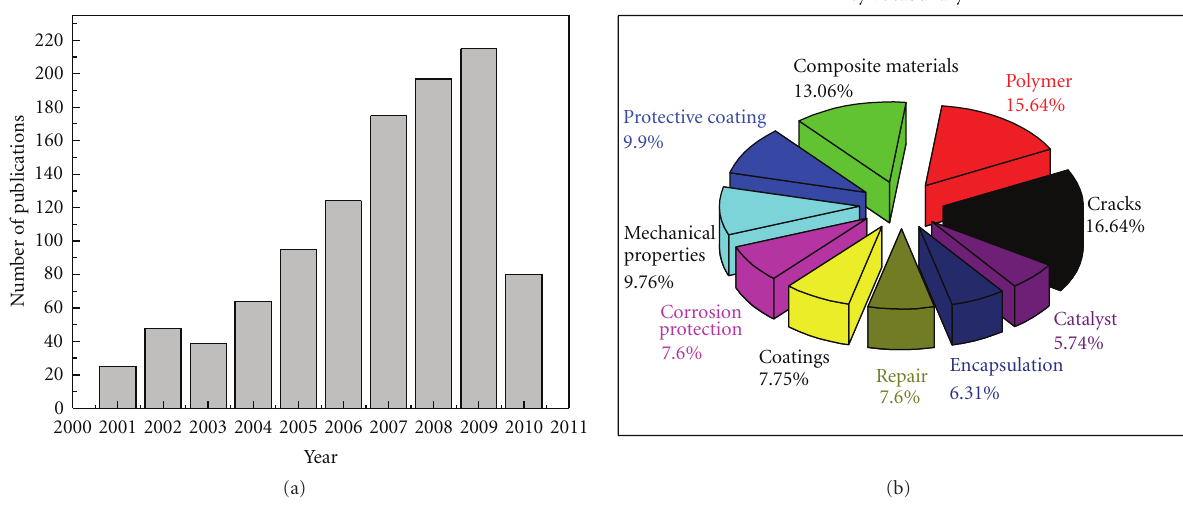
Figure 1: (a) Recent refereed publications related to the field of self healing materials, together with (b) their corresponding distribution of the employed key words vocabulary. All published languages were included. All document types, including journal and conference articles, report paper, conference proceeding, and monograph published chapters were recorded. Statistics are available from 2000 to August 2010 inclusively. Data were collected from Engineering Village web-based information